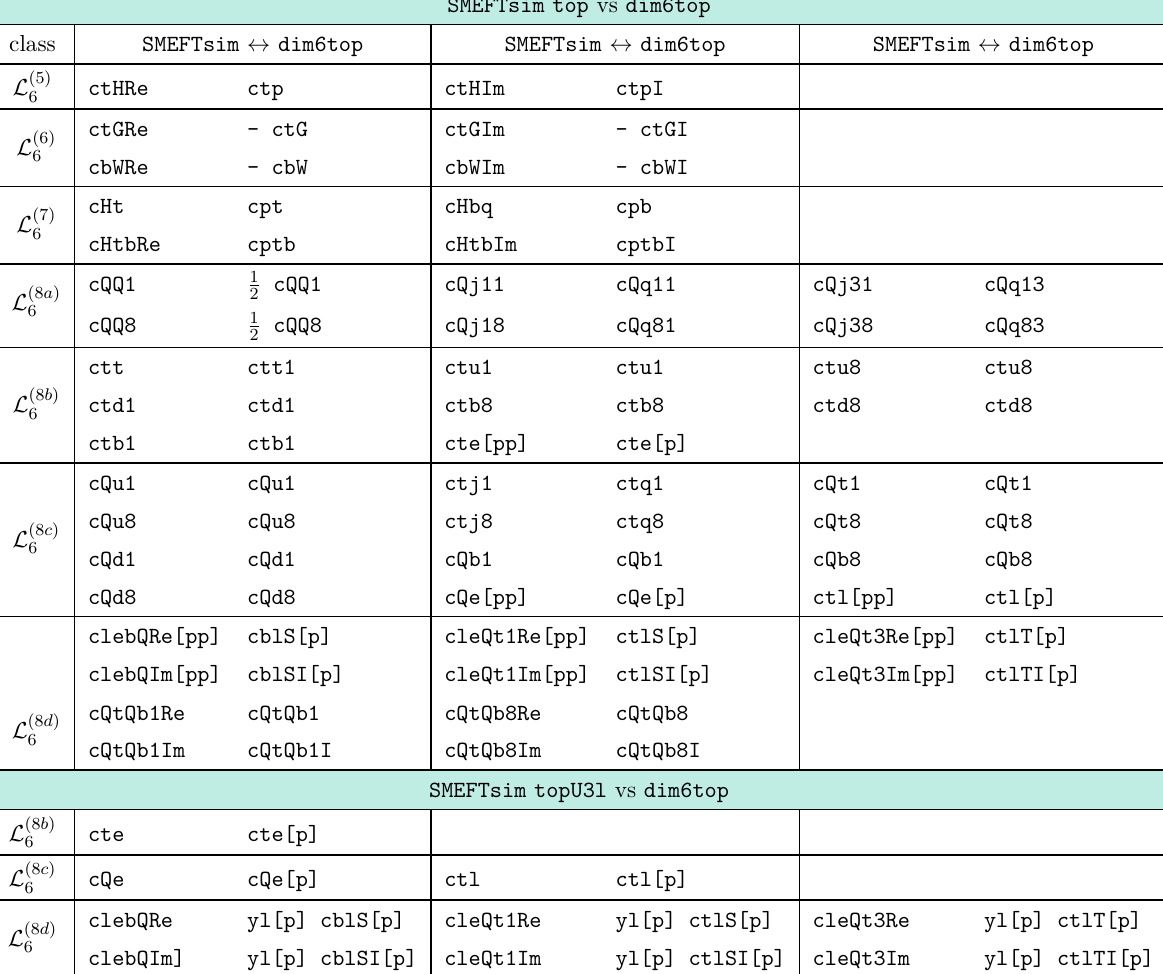
Table 24 . Upper panel: conversion table between the SMEFT parameters defined in the top version of SMEFTsim and in dim6top : parameters with a one-to-one translation. Lower panel: conversion table between the topU3l version of SMEFTsim and dim6top . Only leptonic coefficients are reported, as the other parameters behave identically to the top case. Lepton flavor indices